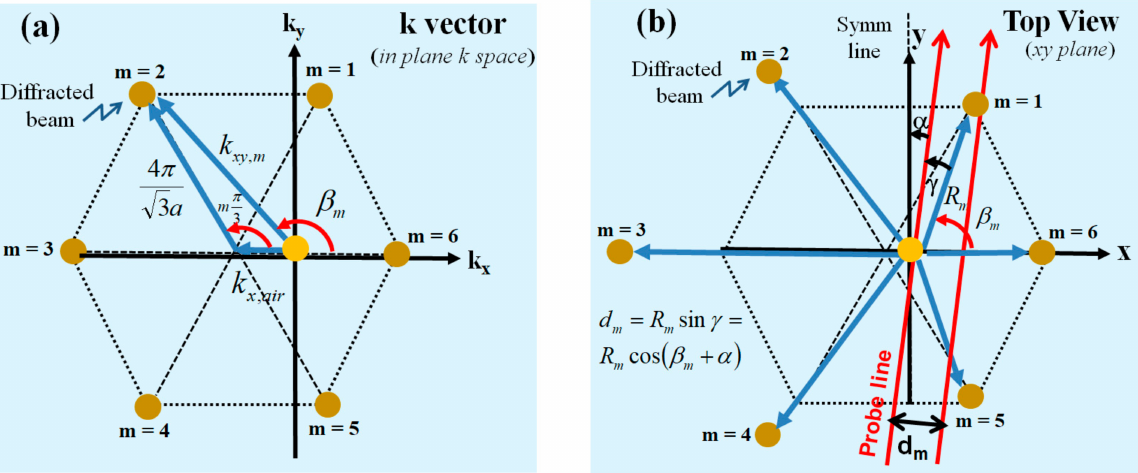
Figure 5. ( a ) Geometric representation of the diffracted beams in the k space; ( b ) Location of the heat sources in the real space (xy